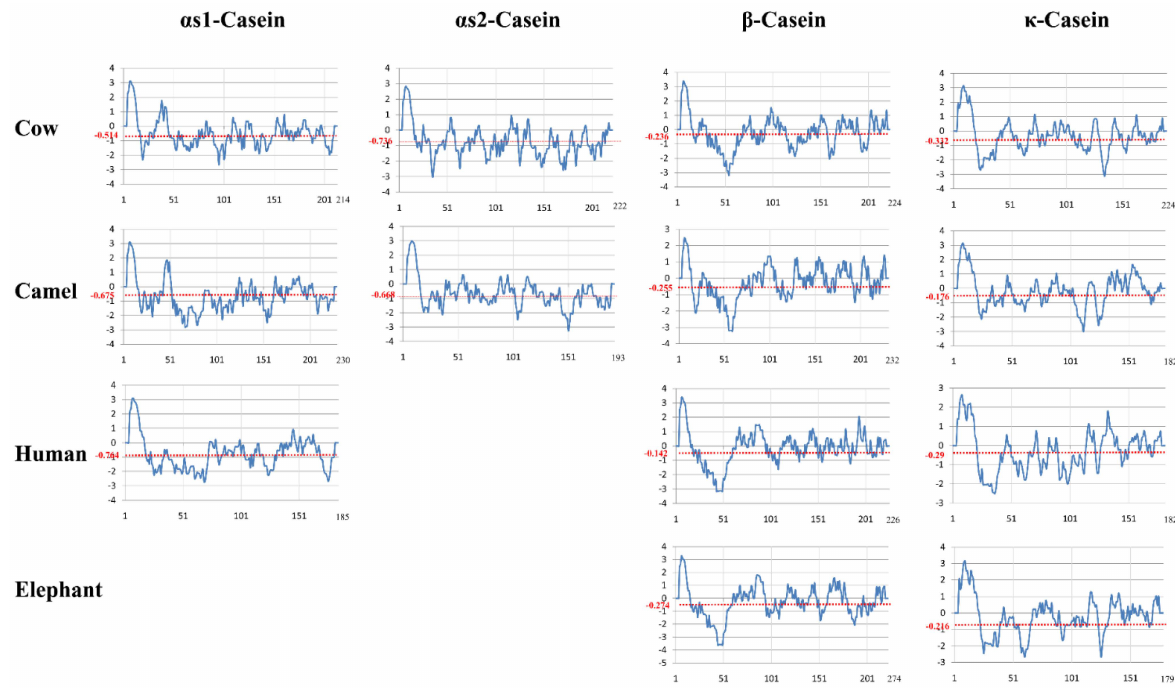
Figure 4. Scoring variation of the hydropathy index for the α s1-, α s2-, β -, and k-caseins of the milks of cow, camel, human, and elephant calculated with a default window size of 9 amino acid residues on the basis of the [51] parameters through Pepinfomodule of EMBOSS